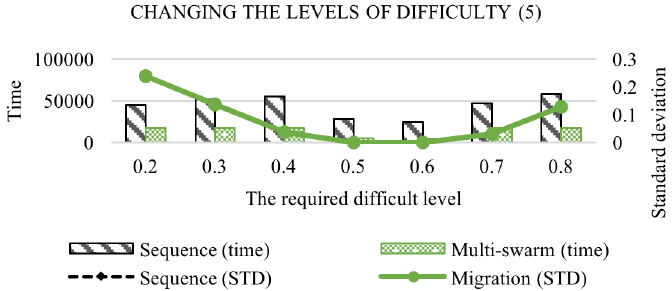
Fig. 4. Changing the levels of di±culty with the parameters in Table 3, column